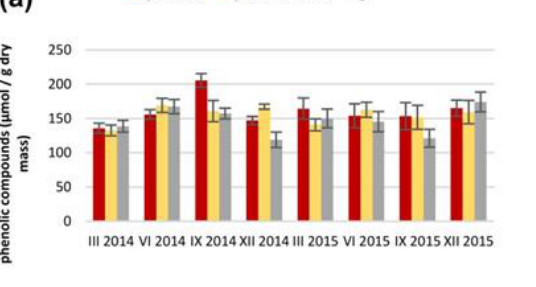
Figure 3. Mean values (±standard error) of ( a , b ) concentrations of phenolic compounds and ( c , d ) tannins in ( a , c ) current-year increments and ( b , d ) 1-year-old increments in control and bud-removed Taxus baccata shoots of females and in male shoots measured in different seasons for two years. 3. Discussion The reproductive effort of females relates to numerous consequences, including re- source allocation and energy requirements (reviewed in [2,52,53]). These specific demands are not limited to the time of flowering but are present throughout the process of seed maturation. This forces females to adjust their metabolism to those demands. Some of those adjustments can be genetically based and some of them may be a response to current conditions. 3.1. Nitrogen Nitrogen is one of the main elements related to the seed production of yew [54]. It is a component of proteins and nucleic acids. However, to the greatest extent, the develop- ment of seeds requires carbon and energy, predominantly obtained from leaves near de- veloping seeds [37 – 39]. Moreover, obtaining energy depends on the allocation of nitrogen to the photosynthetic machinery, as it is used to the greatest extent to build Calvin cycle proteins and thylakoids [43]. In our experiment, nitrogen was allocated by females to gen- erative organs rather than to photosynthetic machinery in leaves from proximity, as leaves from control shoots were visibly depleted of this element. Reproductive allocation relates to N depletion in nearby tissues, and the N concentration is greater in stems that do not bear fruit [50]. Differences observed in bud- and flower-removed experiments show that generative organ removal causes an N increase [55] in vegetative female tissues of dioe- cious species (but it is the opposite for males) [29]. N depletion in reproductive shoots confirms our Hypothesis 1, and it is a common allocation strategy in plants during seed development. The N concentration in female foliage increases with distance from reproductive structures and can have season-long effects [56]. Moreover, we observed that N for devel- oping arils in T . baccata is obtained at the expense of current needles rather than 1-year- old needles. Arils are developed in 1-year increments, and resource transportation from roots leads from previous to current-year increments. Therefore, we presume that N is not